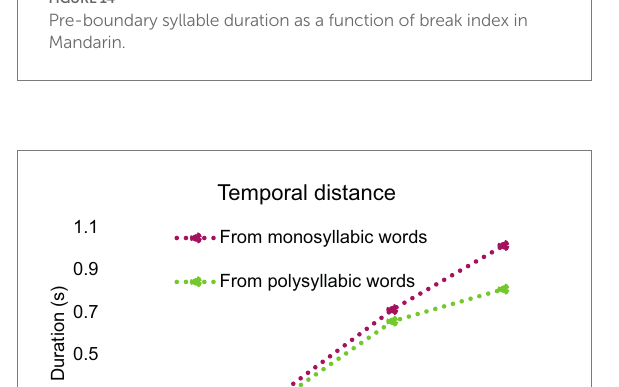
FIGURE 14 Pre-boundary syllable duration as a function of break index in Mandarin.